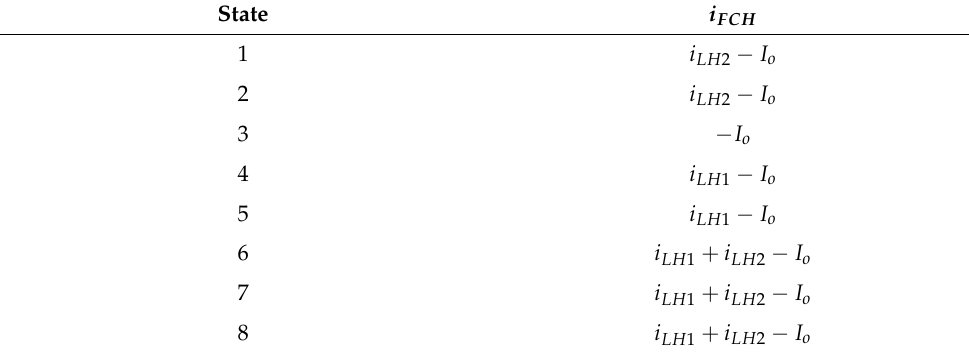
Table 1. High-side capacitor current for eight operating states of a Z-type interleaving method.